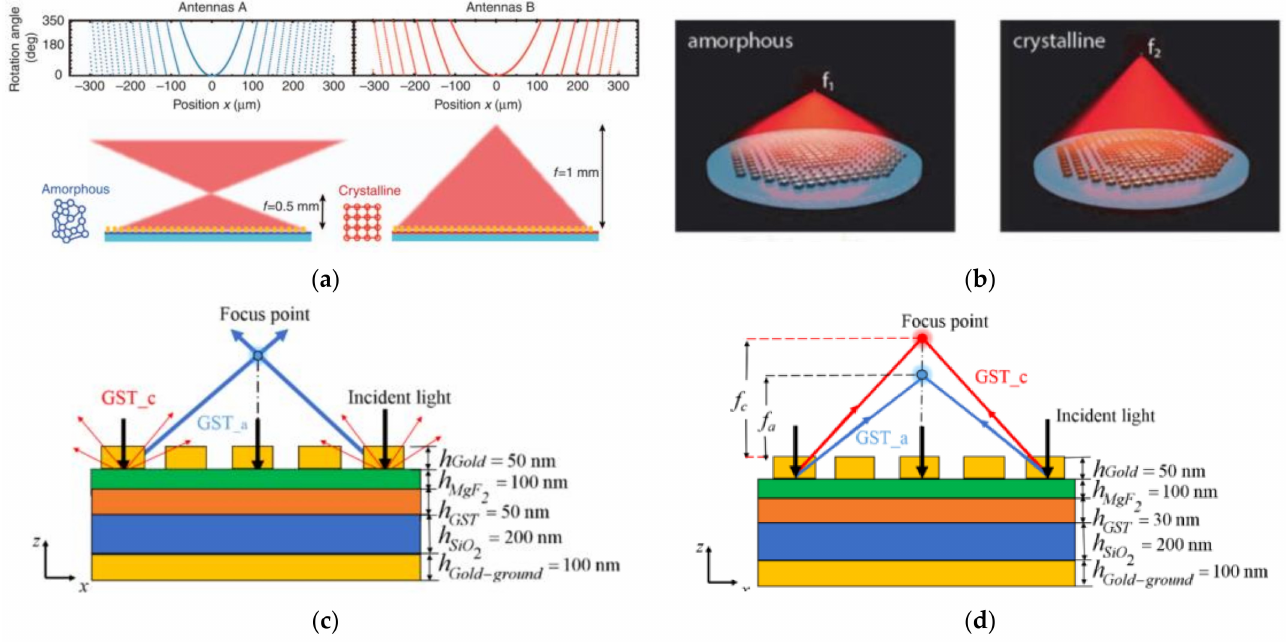
Figure 6. ( a ) The plasmonic metasurface composed of two sets of nanoantenna that interact with incident light alternately to produce a variable quadratic phase for bifocal lensing; ( b ) the artistic impression of a tunable metalens composed of GSST meta-atoms with bifocal length at 1.5 and 2.0 mm in the amorphous and crystalline states, respectively; ( c ) a type of mid-IR metalens with switchable focusing in the amorphous (focusing) and crystalline (defocusing) states and ( d ) tunable focal length in both states—( a , b ) reproduced with permissions from [149,154]; ( c , d ) reproduced with permissions from